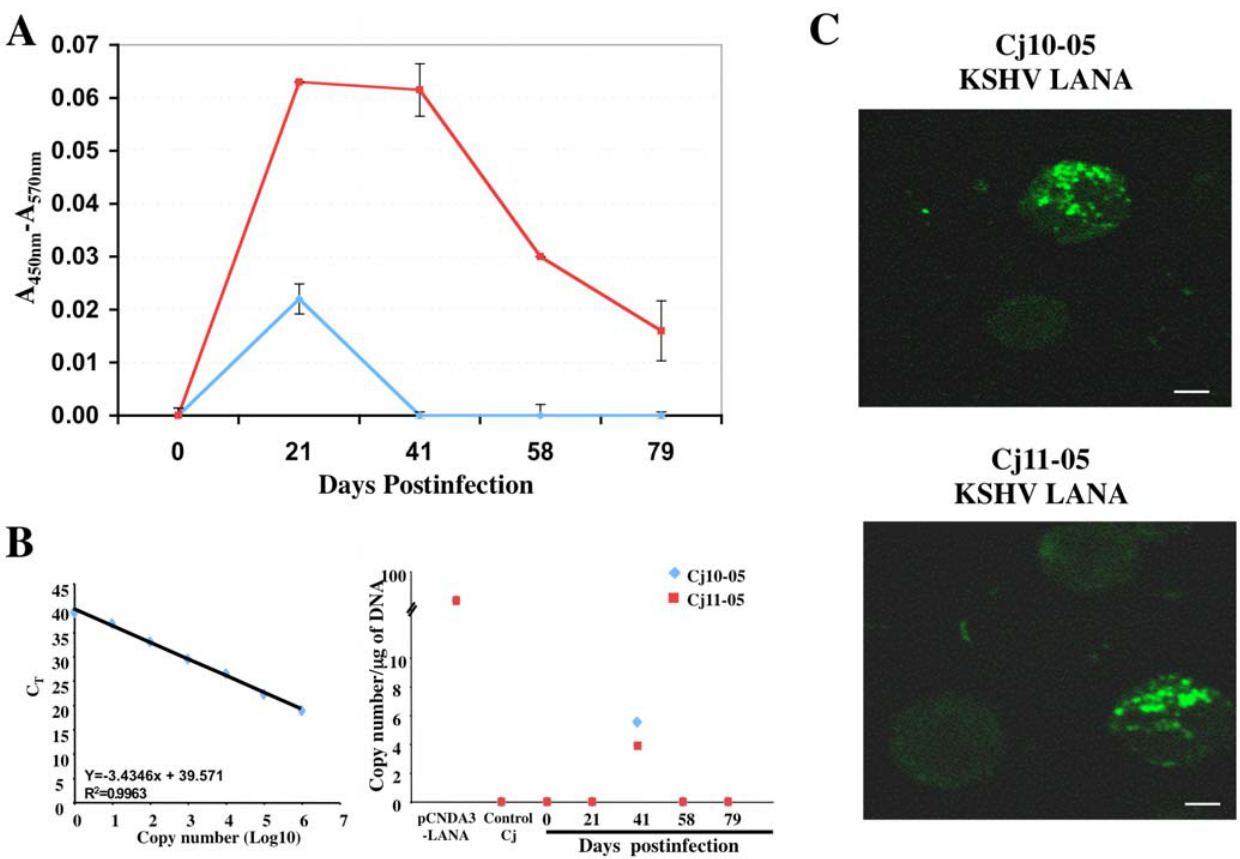
Figure 6. Oral infection of common marmosets with rKSHV.219. ( A ) Anti-KSHV ELISA using the sera of Cj10-05 and Cj11-05 (1:5 dilution) was performed as described in Figure 1A. The results show the averages of two repeats and standard deviations. These assays were reproduced by four independent occasions. ( B ) Real-time PCR of genomic DNA (100 ng) taken from orally infected marmosets Cj10-05 and Cj11-05 using LANA-specific primers at various time points. Purified genomic DNA from Vero.rKSHV.219 cells (P) was included as a positive control. The viral DNA copy number/ m g of DNA was calculated using a standard curve with pcDNA3-LANA DNA. The results show the averages of two repeats with standard deviations. ( C ) Detection of the LANA protein by confocal microscopy. PBMCs from orally infected marmosets Cj10-05 and Cj11-05 were subjected to immunostaining with an anti-LANA antibody, followed by confocal microscopy. The scale bars represent 2 m m.